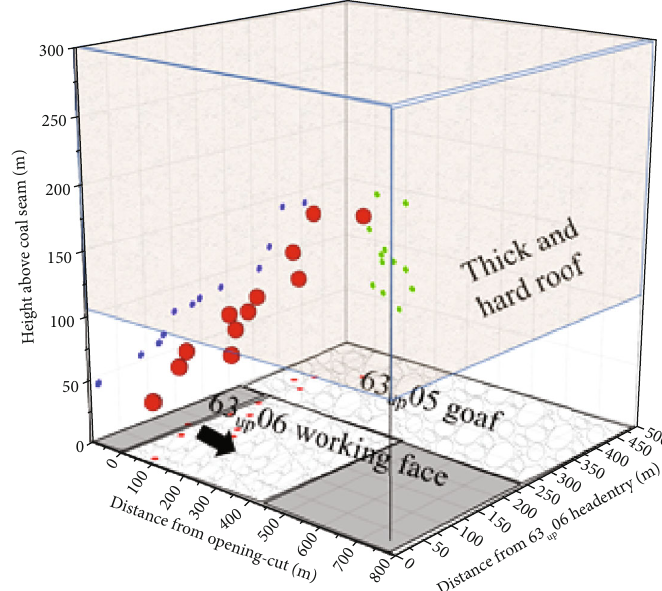
Figure 19: Statistics of high-energy vibration events in the 63